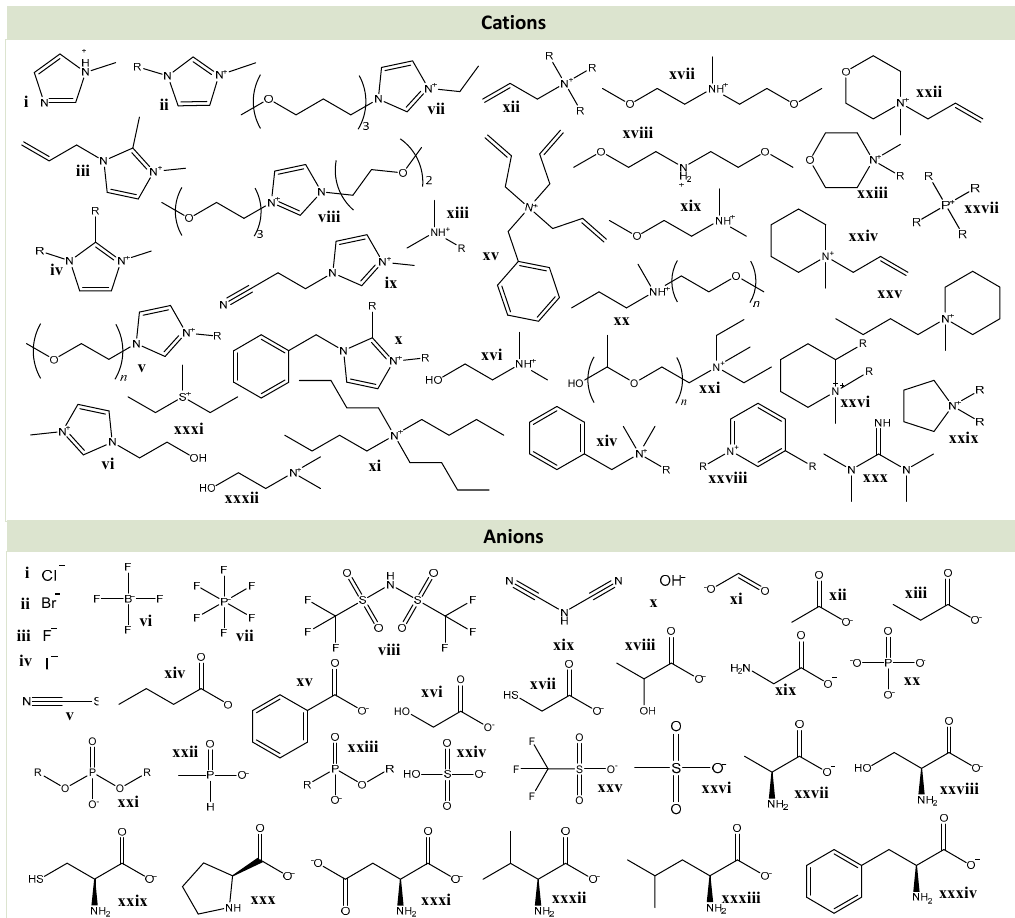
Figure 2. Chemical structures of the IL cations and anions reviewed in this work.